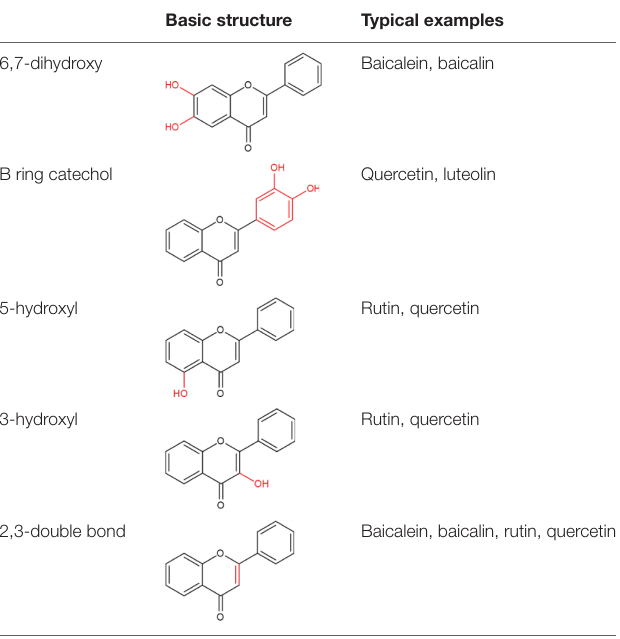
TABLE 2 | Iron binding sites of